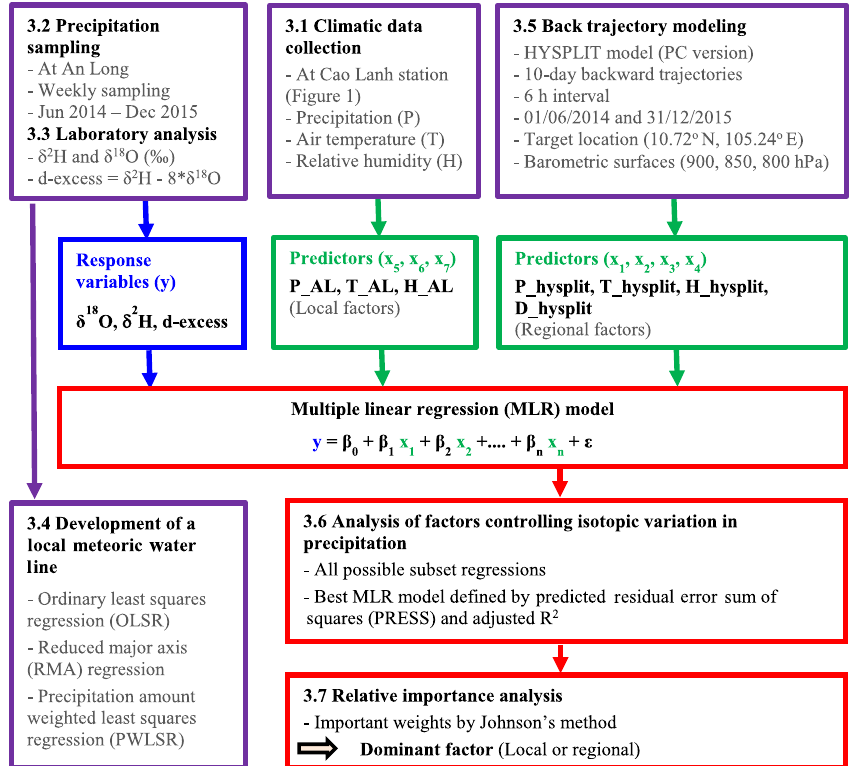
Figure 4. Methodology used in the study. Local precipitation (P_AL), air temperature (T_AL), and relative humidity (H_AL) at An Long. Precipitation amount (P_hysplit), mean temperature (T_hysplit) and relative humidity (H_hysplit) along the transport pathways, and the length of backward trajectories